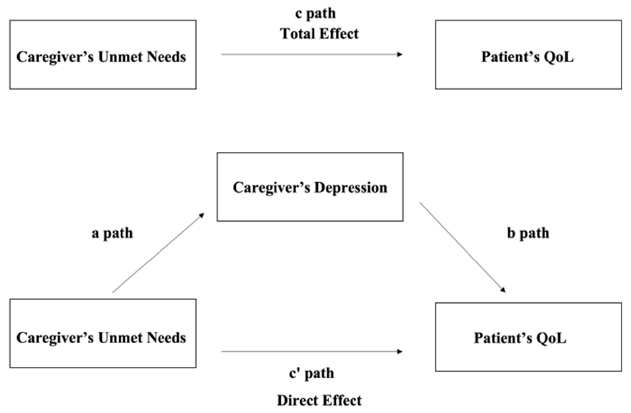
Figure 2. Hypothesized model.